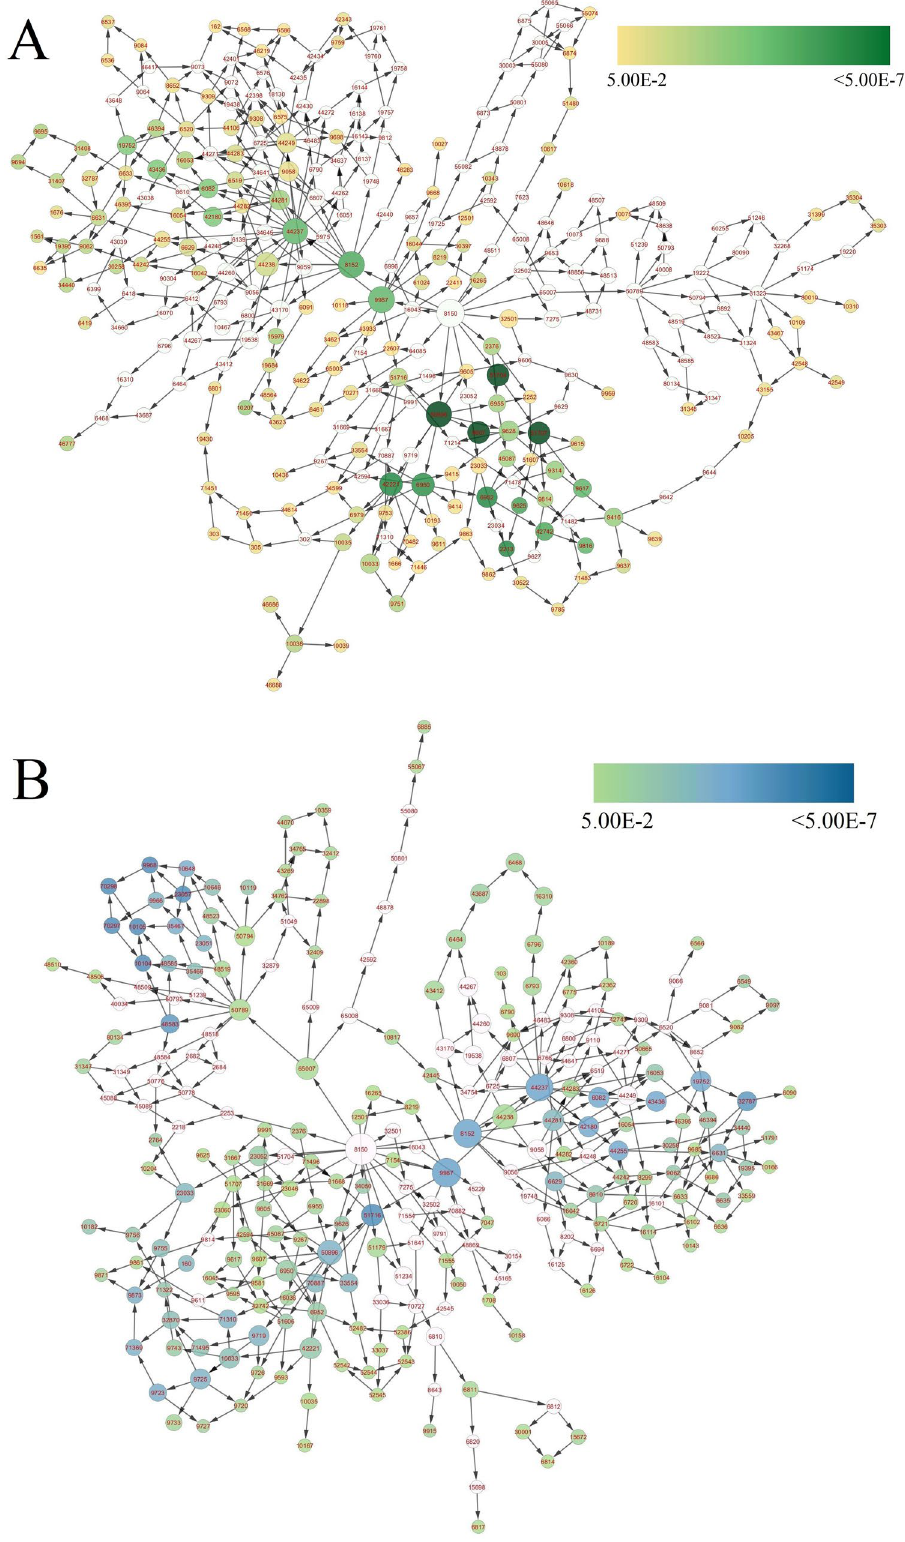
Figure 16. Gene ontological enrichment analysis of topologically selected up-regulated ( A ) and down-regulated ( B ) genes based on biological process using BiNGO (version 3.0.4) considering Arabidopsis as model organism. Hypergeometric test was conducted, considering p value cut off ≤ 0.05. Size of the node was proportional to the number of gene (transcripts) present under a particular nodal category. Node colour shades were according to the significance level. For up-regulated genes white represents no significant differences, yellow and green colour shade represents significance level at p = 0.05 and < 0.0000005 respectively. Similarly for down-regulated genes white represents no significant differences, green and blue colour shade represents significance level at p = 0.05 and < 0.0000005